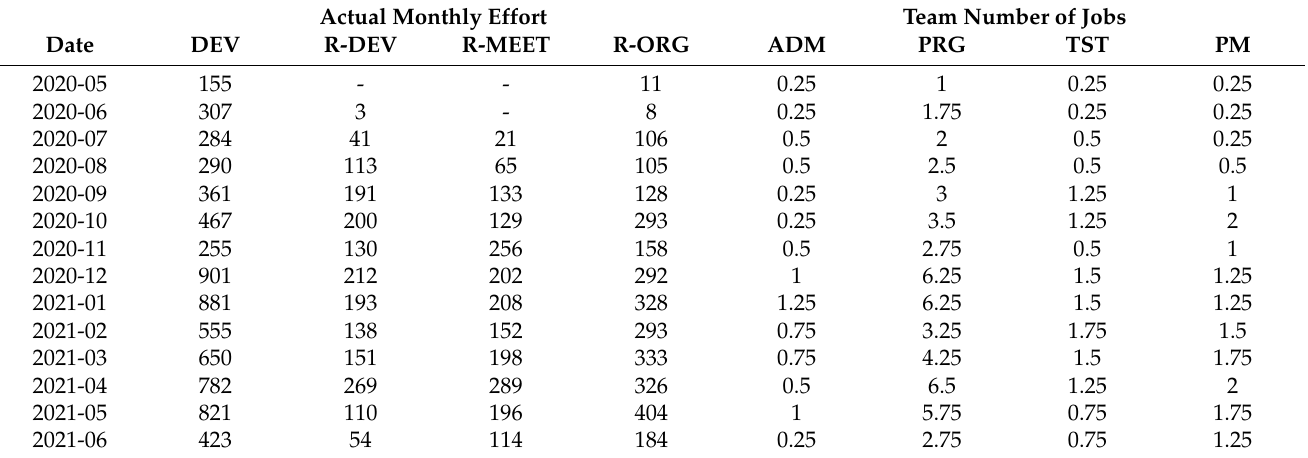
Table 3. Monthly work of the P6 project and reconstructed composition of the project team. Actual Monthly Effort Team Number of